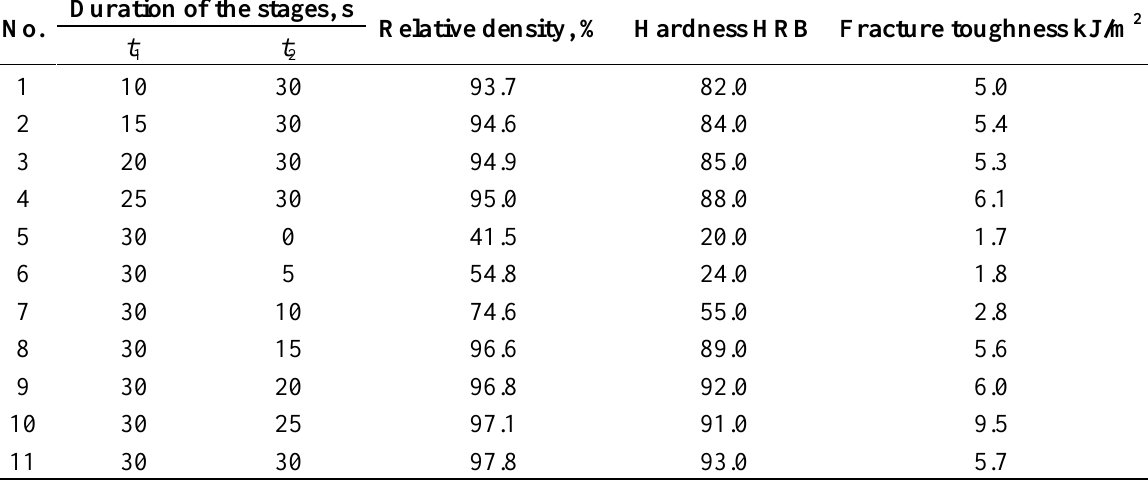
Table 1. Hardness and relative density of Cu-Sn materials consolidated by two-stage electric pulse sintering using different duration of the